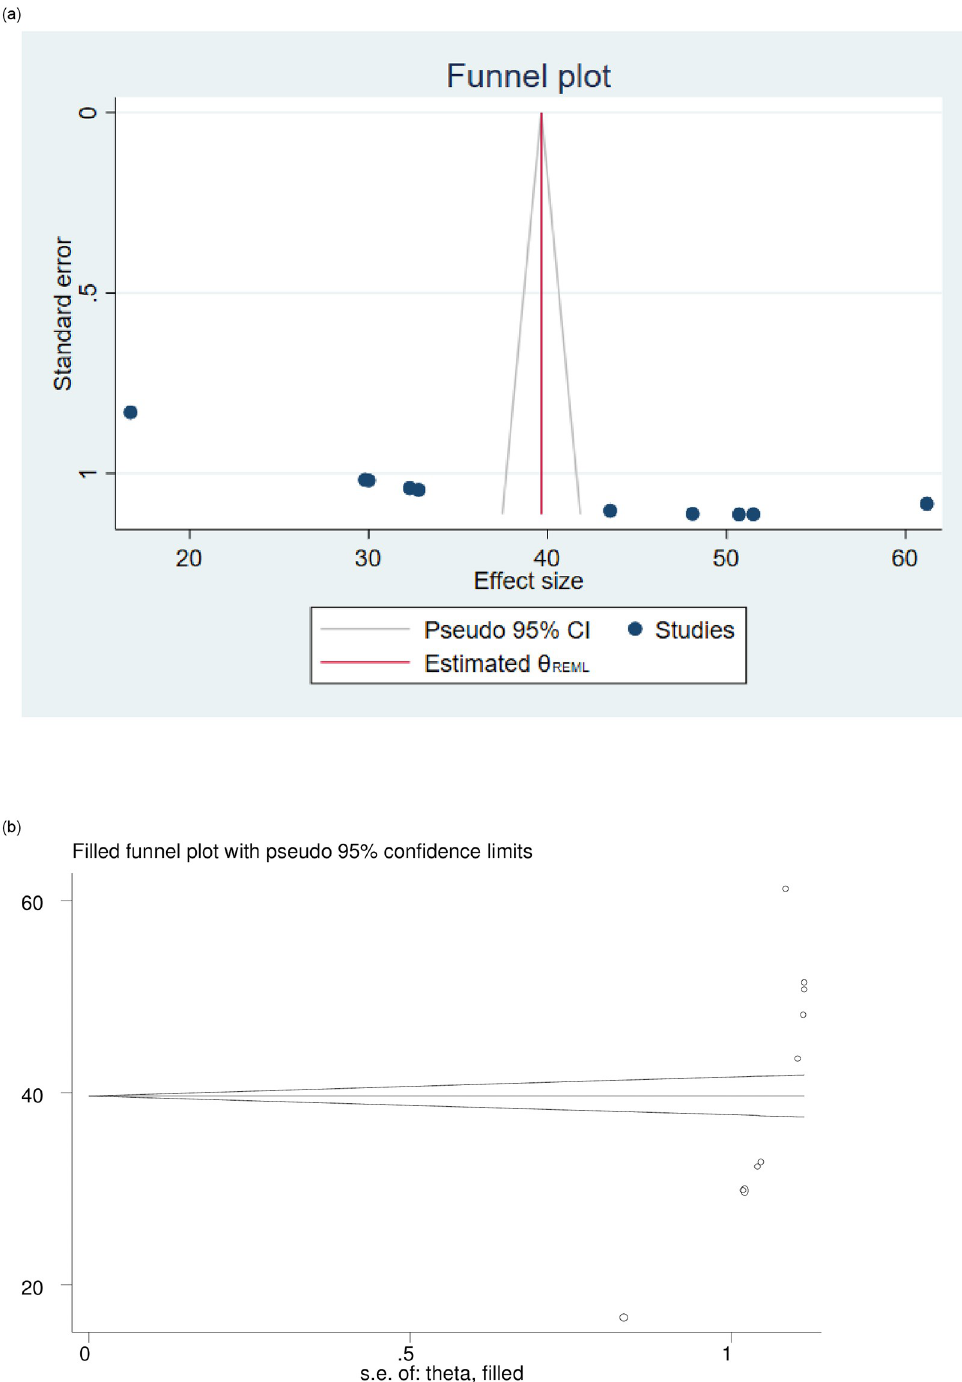
Fig 3. a: Funnel plot for assessing publication bias of the prevalence of practices of active management of the third stage of labor in Ethiopia. b: Funnel plot of the 12 studies’ fill and trim analysis results for adjusting publication bias.